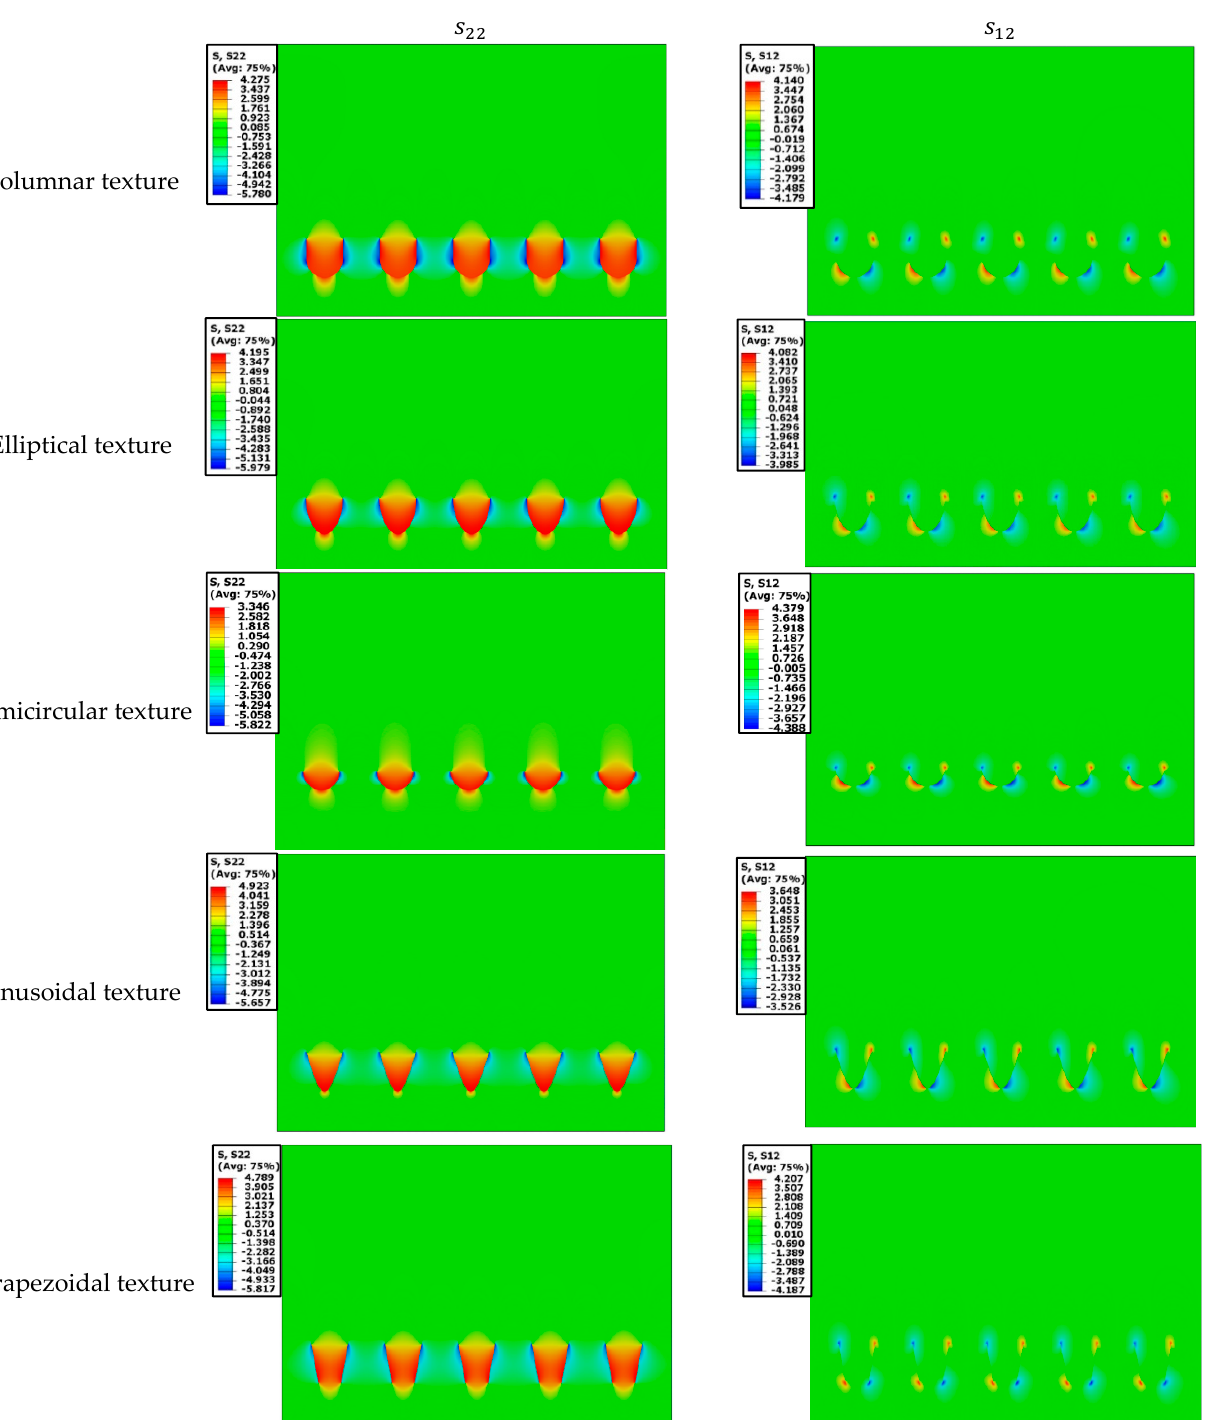
Figure 5. Prestress field distribution of five texture coatings: s 22 and s 12 .